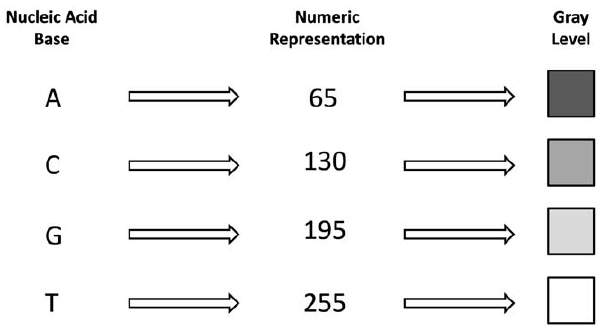
Figure 4. Base Codification. Each nucleic acid base is represented by a specific number which represents the gray level of a pixel.